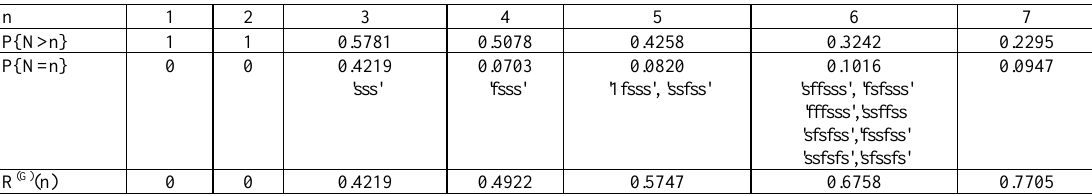
Table 2. R (G) (n) for n 1 =3, k cs =3, p 1 =0.75, p 2 =0.5, k s